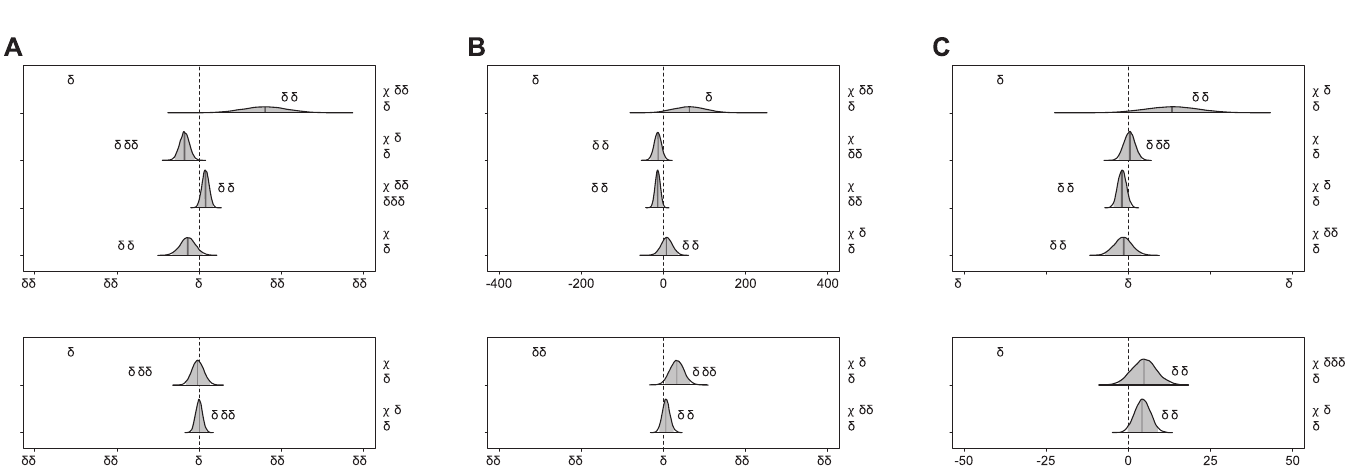
Fig 2. Posterior 95% credible intervals for the estimated differences in gait temporal parameters. (A) The 95% credible intervals and their probability distributions (shaded areas) describe the effects and interaction of sex and age (with locomotion speed as a covariate) on the stance duration. Positive values indicate longer stance times in females than in males and in older than in younger adults. Effect size in the style of Hedges are shown as δ t . A Bayesian equivalent of R 2 is presented as R 2 Bayes . The χ 2 and p-values resulting from a frequentist linear mixed model analysis are reported as additional information. (B) The same as in panel (A), but for the swing phase duration. (C) The same as in panel (A), but for the cadence or number of steps per minute.